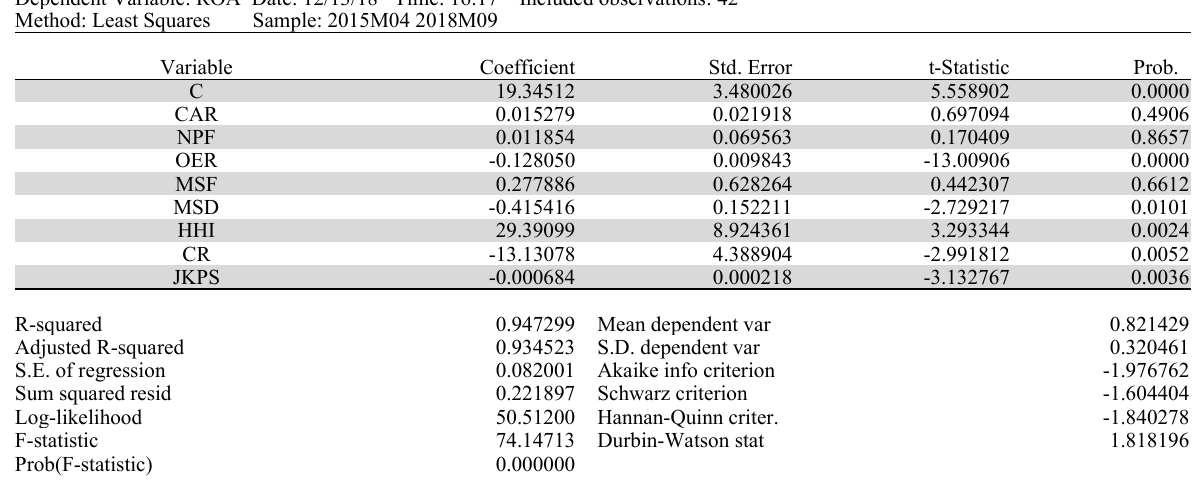
Result of Long Term Relationship between